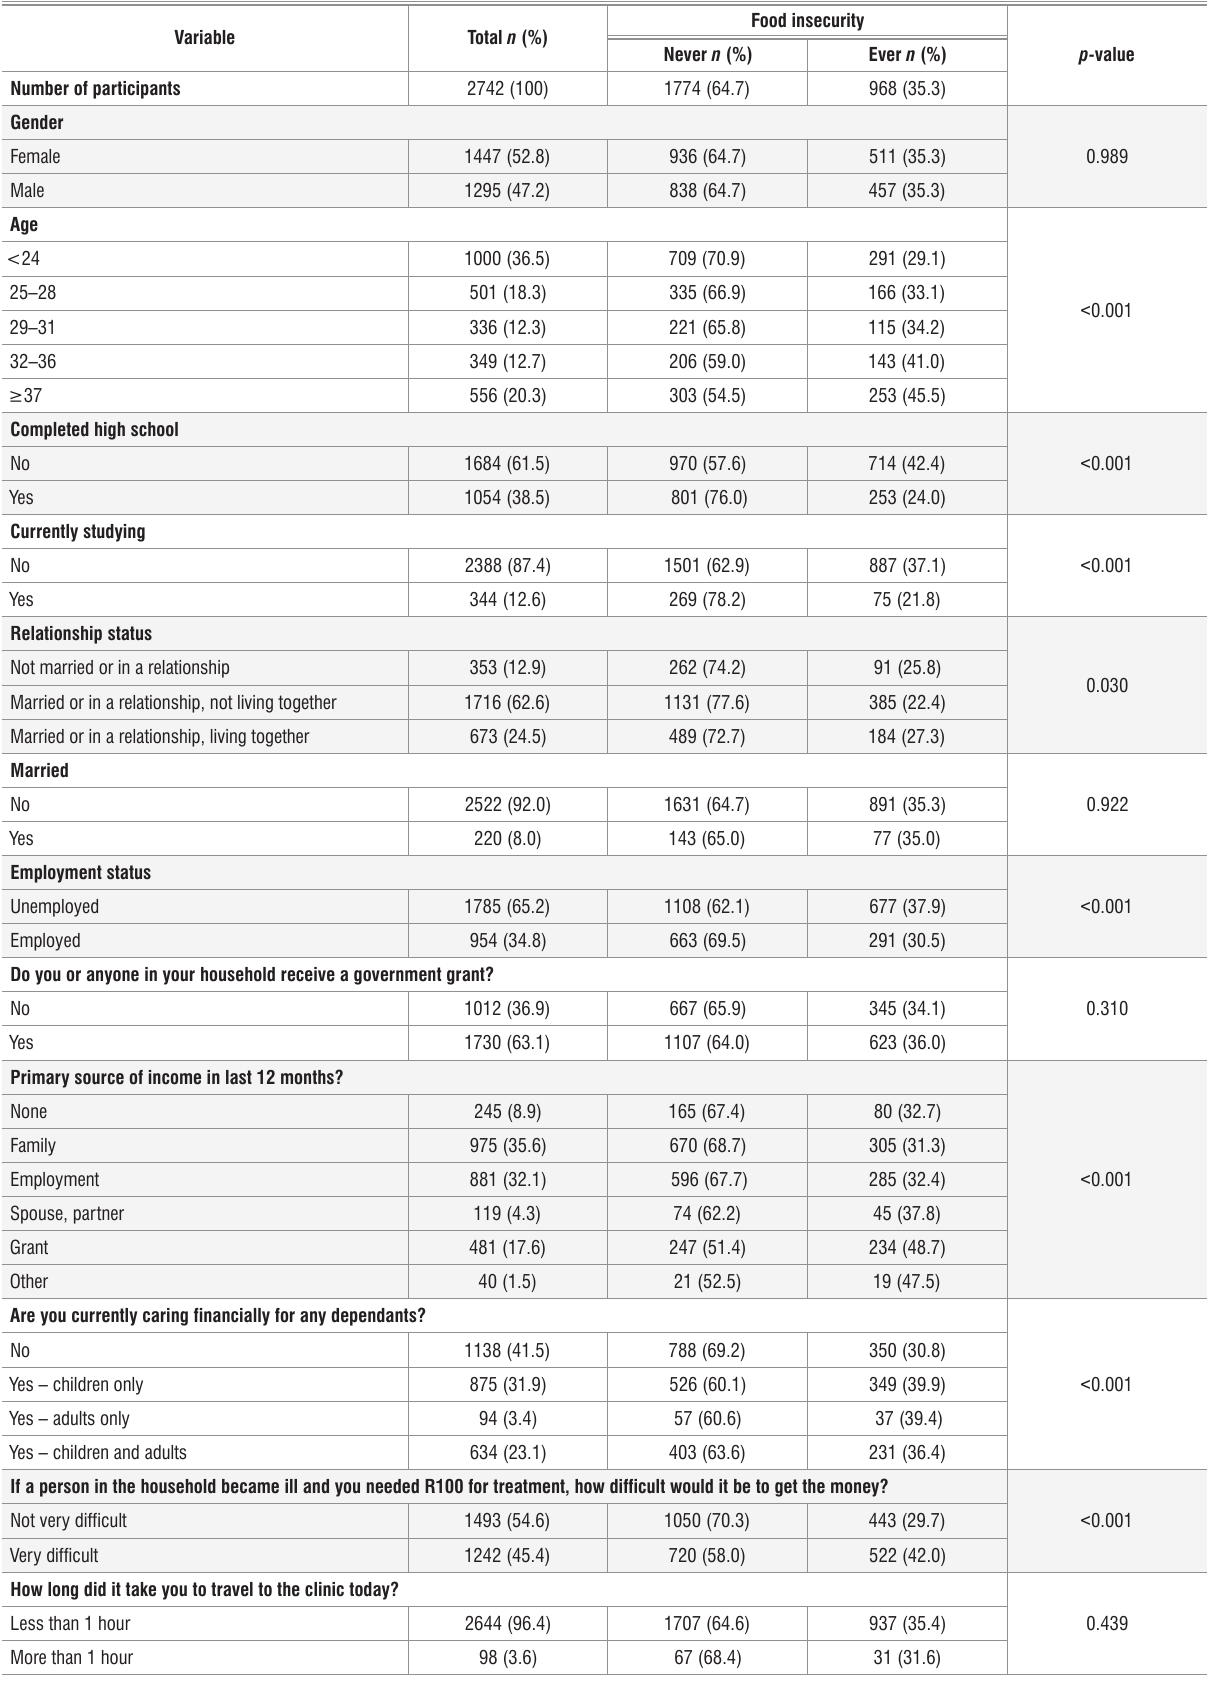
Table 1: Description of the study sample in association with food insecurity among adults presenting for HIV counselling and testing at three primary healthcare clinics in KwaZulu-Natal, South Africa, 2010–2012